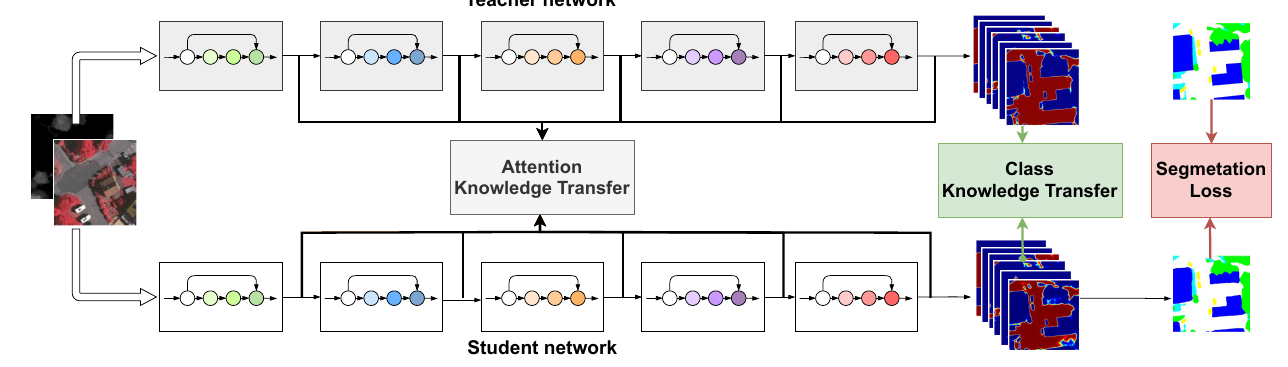
Figure 5. Illustration of our knowledge distillation